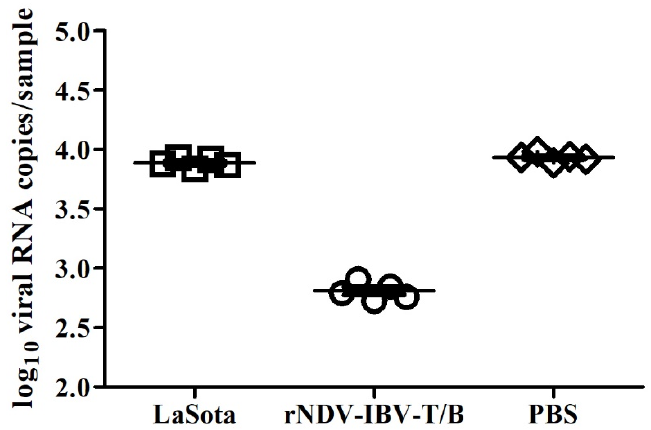
Figure 5. RT-qPCR quantitation of IBV viral shedding in challenged chickens. Four days post-IBV challenge, tracheal swab samples were collected from five chickens and viral RNA was quantitated via RT-qPCR. Copy numbers of IBV viral RNA were determined using a standard curve and log10 values plotted on the scatter plot shown. Horizontal lines indicate means and error bars indicate ± SEM.